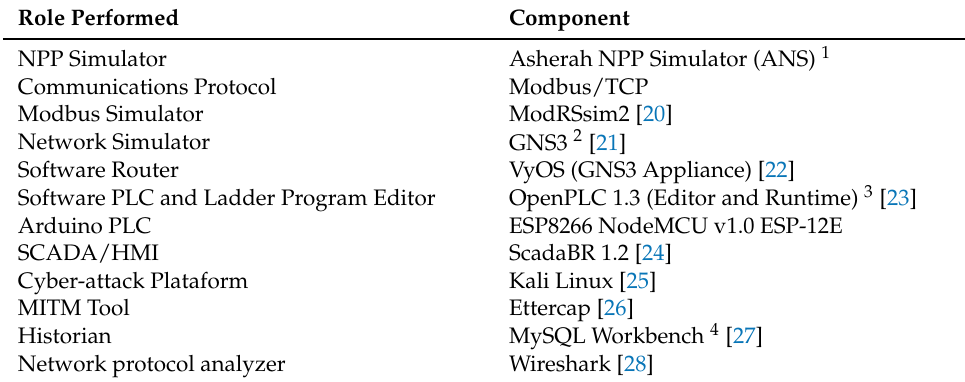
Table 1. Nuclear testbed. List of